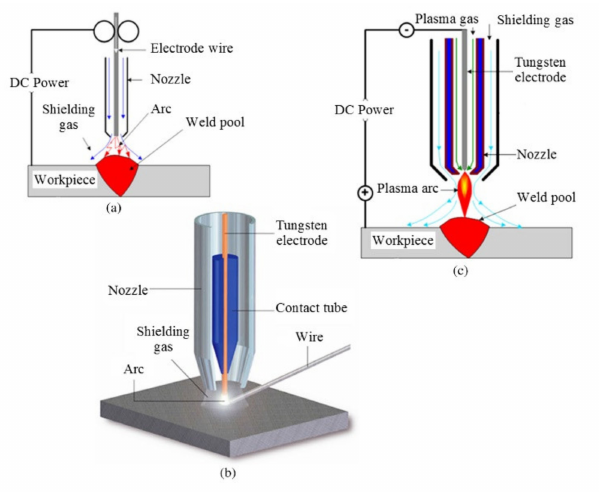
Figure 1. Wire Arc Additive Manufacturing. Principle of WAAM with: ( a ) MIG; ( b ) TIG; ( c ) Plasma Arc Welding. Reprinted from Ref. [6].